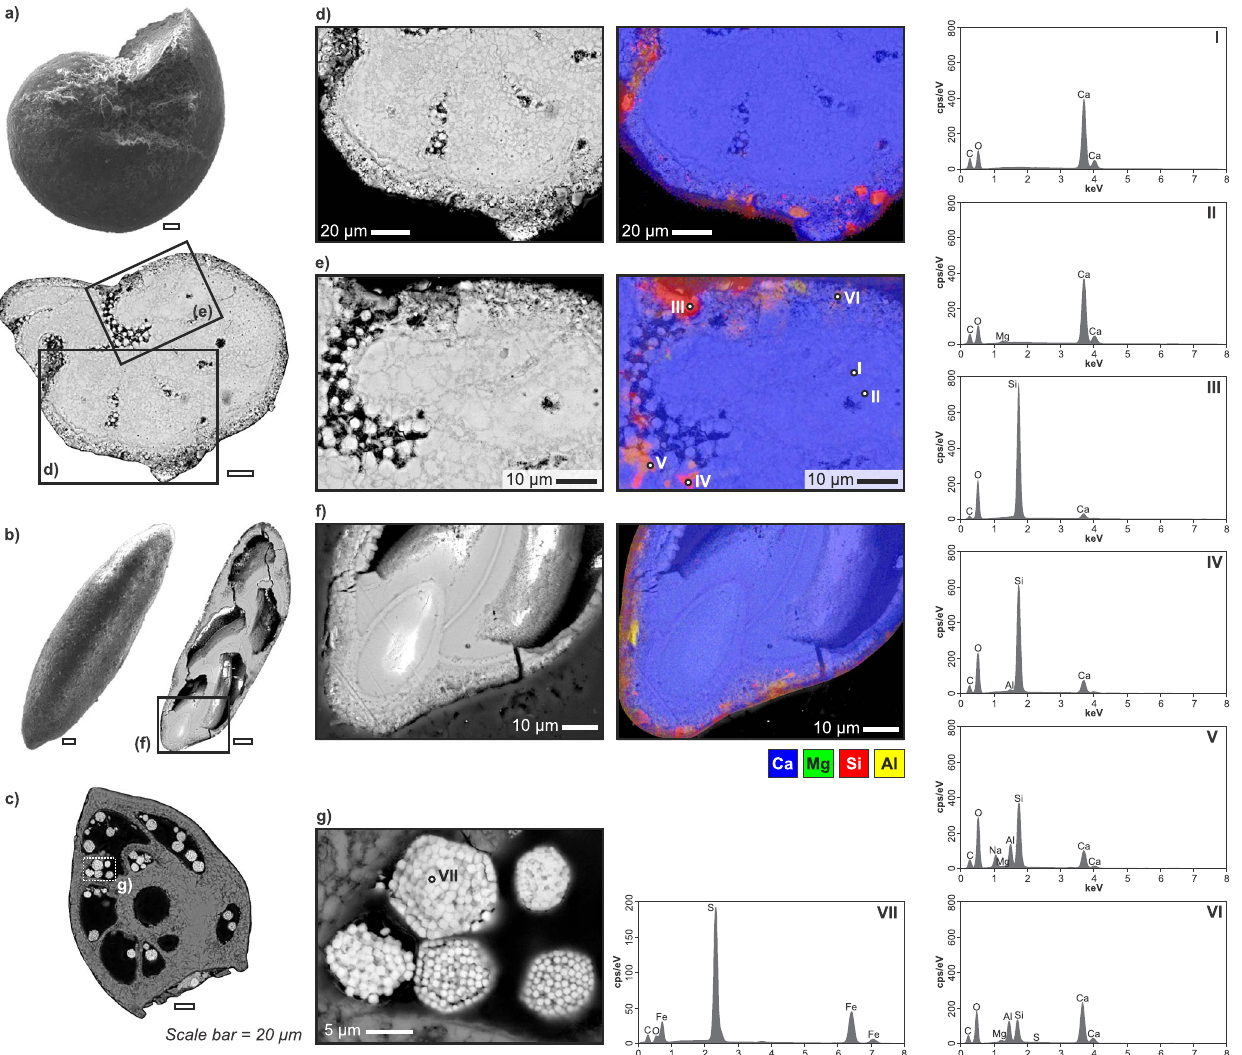
Fig. 3 Examples of diagenetic alterations in foraminiferal tests from methane sites. The images are from specimens from ME I, where the sediments were affected by past methane emissions and exhibit test alteration evidenced by backscatter-scanning electron microscopy (SEM) images ( a , b ) and energy-dispersive X-ray spectroscopy (EDS) images ( c – g ). SEM images and backscatter electron (BSE) images from cross-sections of the benthic foraminifera Melonis barleeanus ( a ) and Fursenkoina cf. acuta ( b ) exhibit the presence of methane-derived authigenic carbonate (MDAC) coatings around the calcite test. In M. barleeanus ( a ), the primary test with evident pores is still visible on the upper left side of the image corresponding to the fi rst chambers. Fursenkoina cf. acuta ( b ) tests have lost the optically smooth surface texture, transparency and re fl ectance. They are pervaded by a pervasive coating of MDAC, presenting moderate diagenetic alteration, according to ref. 94 . The BSE images of cross-sections of M. barleeanus ( d , e ) and Fursenkoina cf. acuta ( f ) show the presence of the MDAC coating throughout the tests. The secondary electron images show the chemical characterisation of foraminifera primary tests and secondary overgrowth, presented as point analyses (I – VI in panel d , with relative spectra) and as compositional maps (blue indicates calcium, Ca; green indicates magnesium, Mg; red indicates silicon, Si; yellow indicates aluminium, Al). SEM image and backscatter electron (BSE) images from cross-sections of the benthic foraminifera Cassidulina teretis ( c – g ) show the presence of rounded clots formed by micrometric pyrite crystals precipitated inside the test (point analyses VII in panel g and relative